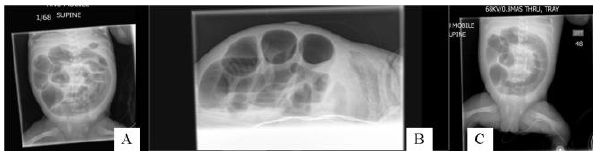
Figure 2: (A): AXR of Case 2 on day 44 of life, showing dilated bowel loop surrounding a cyst like appearance in the central abdomen; (B): Lateral shoot through x-ray of the abdomen of case 2 on day 44 of life showing dilated bowel in the central abdomen. No free air is seen; (C): AXR of Case 2 on day 46 of life, showing fixed dilated bowel loop surrounding a cyst like appearance in the central abdomen.